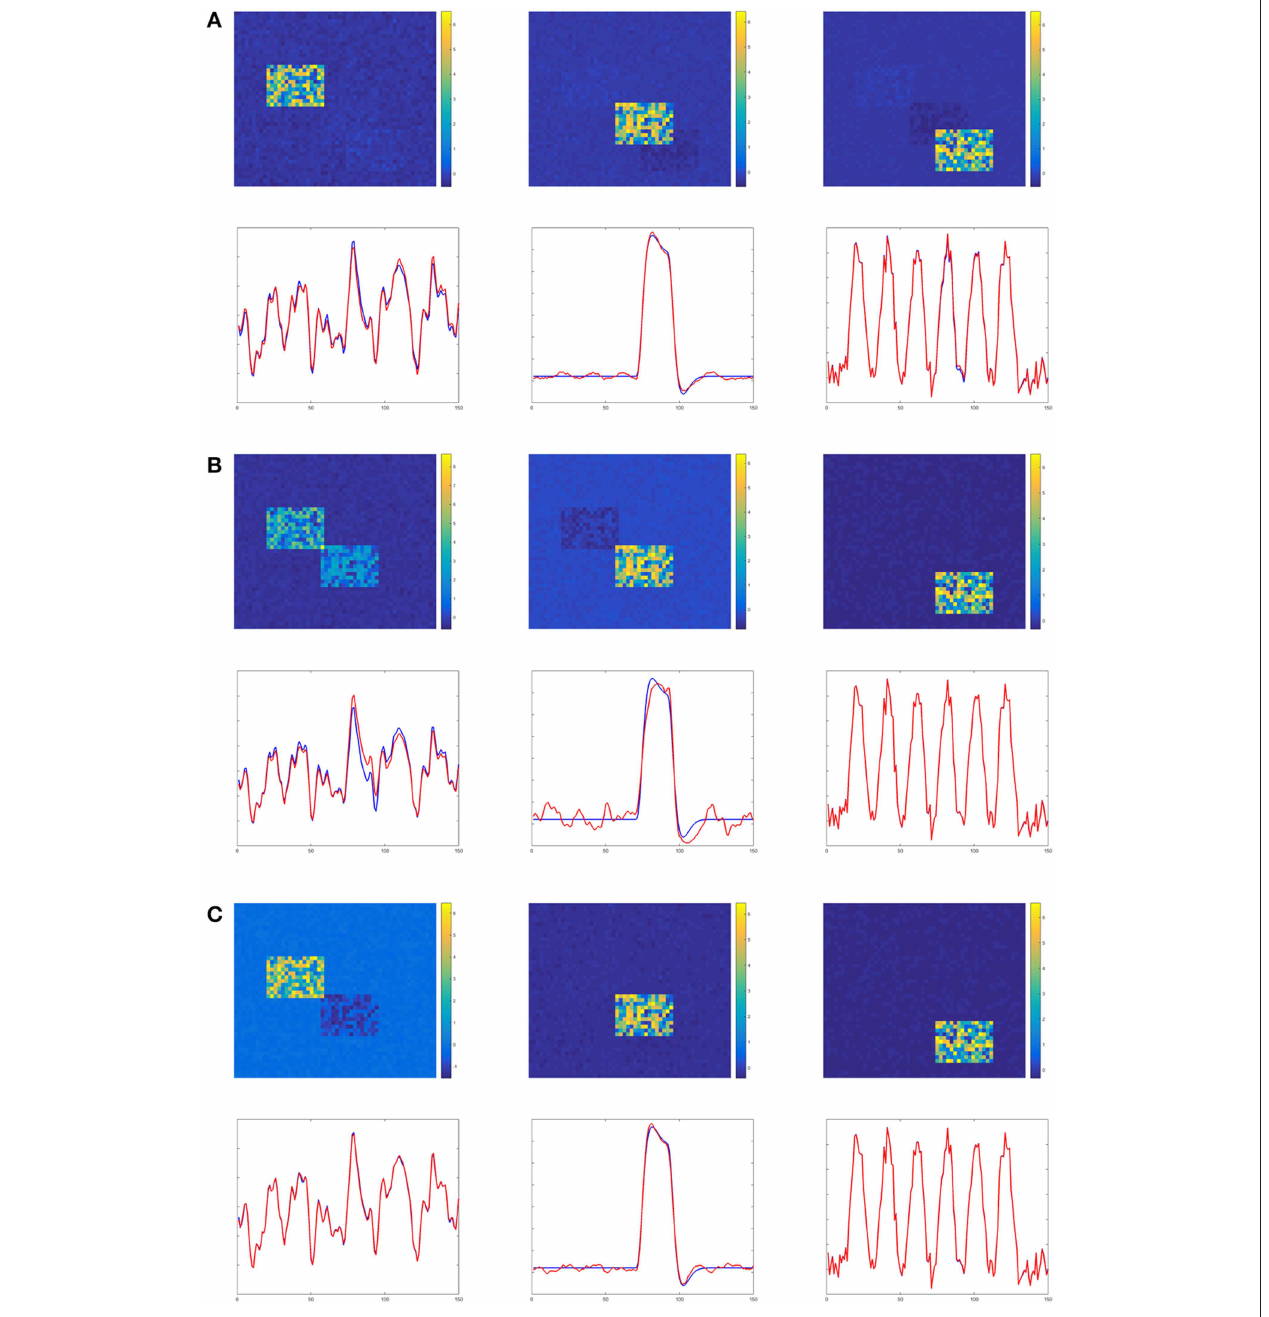
FIGURE 6 | Experiment C in the case of low noise, low overlapping and high collinearity. It shows PARAFAC suffers from high collinearity issue. (A) TPICA. (B) PARAFAC. (C) Proposed Non-Gaussian penalized PARAFAC.